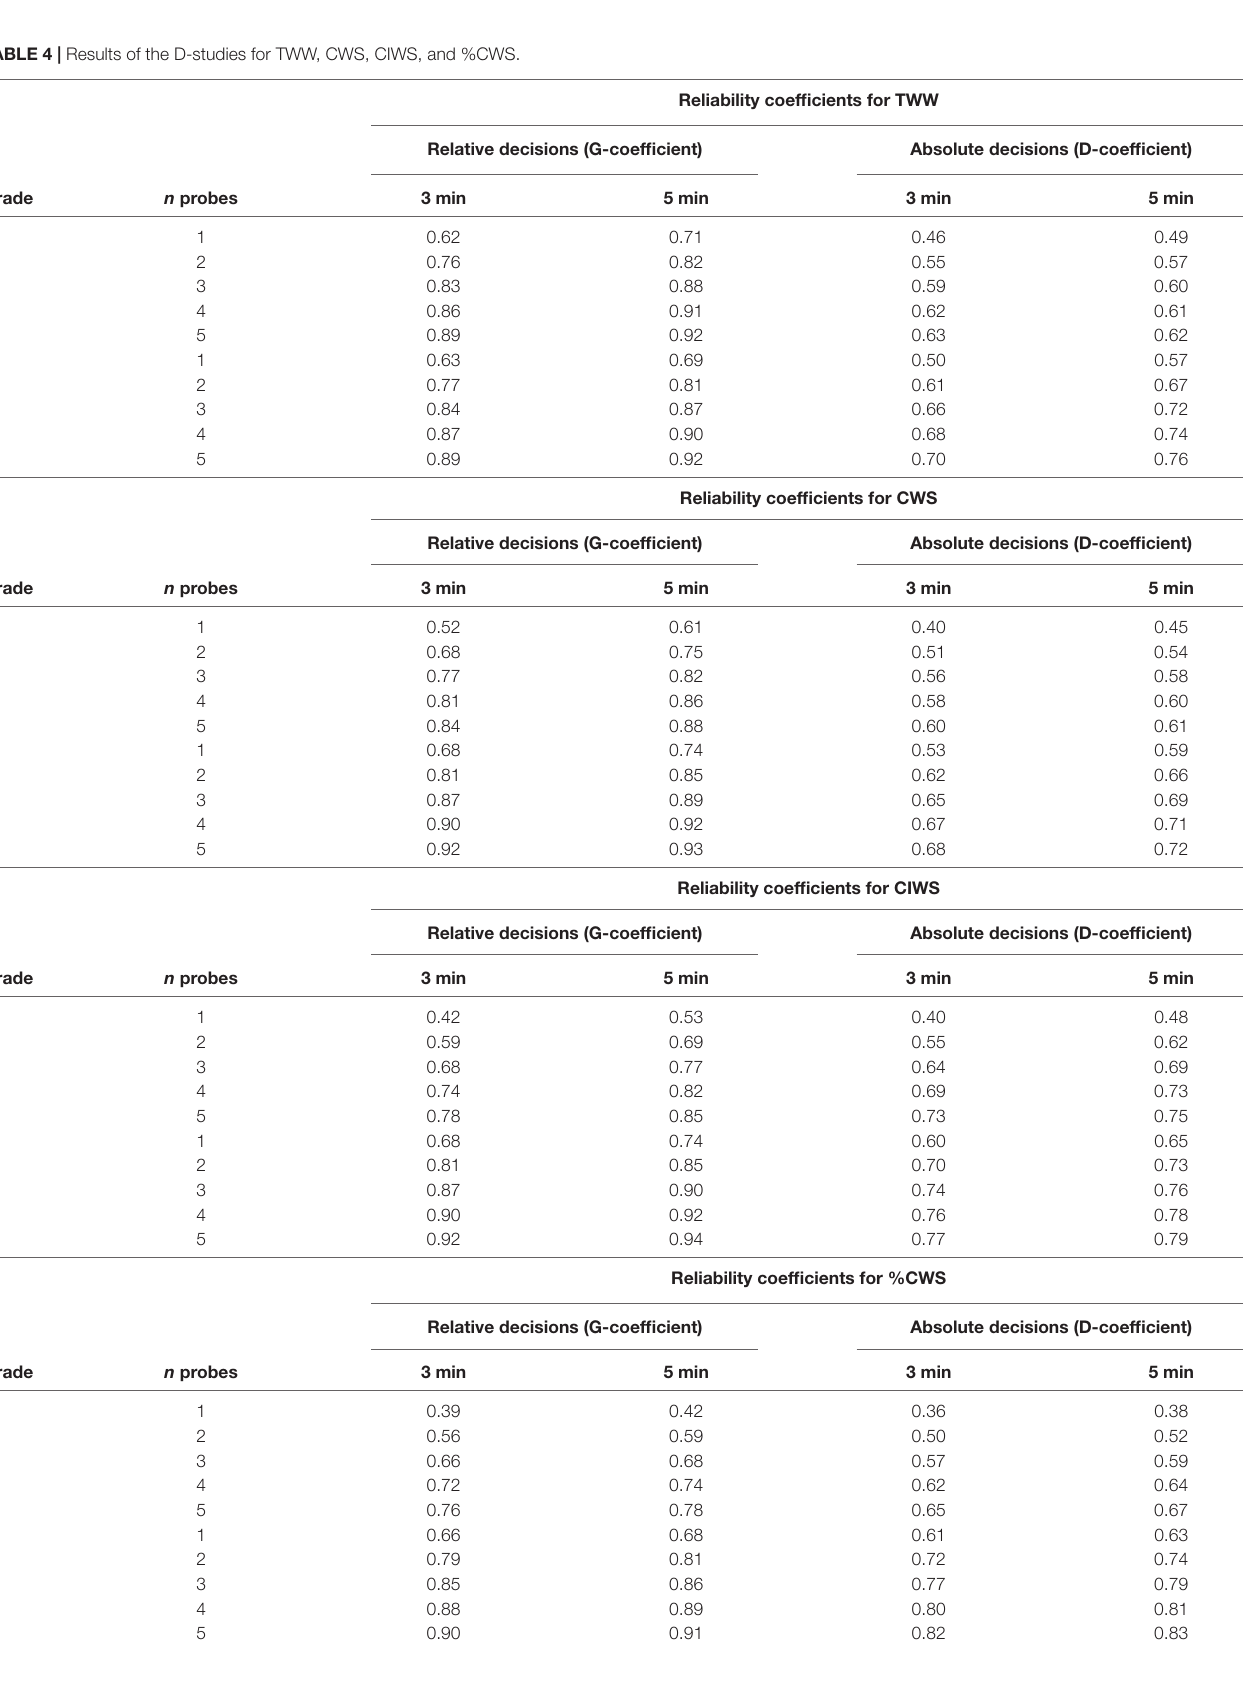
TABLE 4 | Results of the D-studies for TWW, CWS, CIWS, and %CWS.